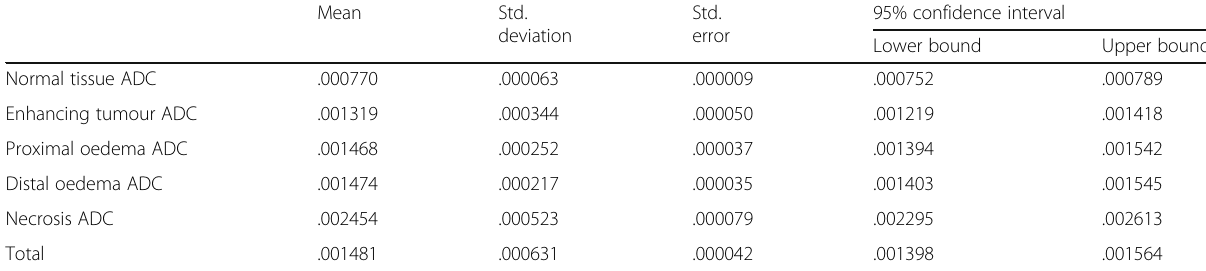
Table 1 Means and 95% C.I. of the ADC values (mm 2 /s) at each tumour region Mean Std. deviation